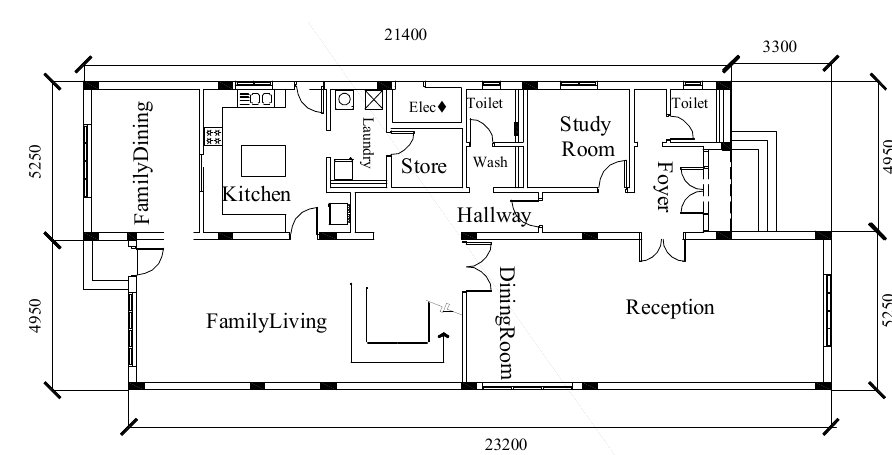
Figure 1. Building first floor plan.